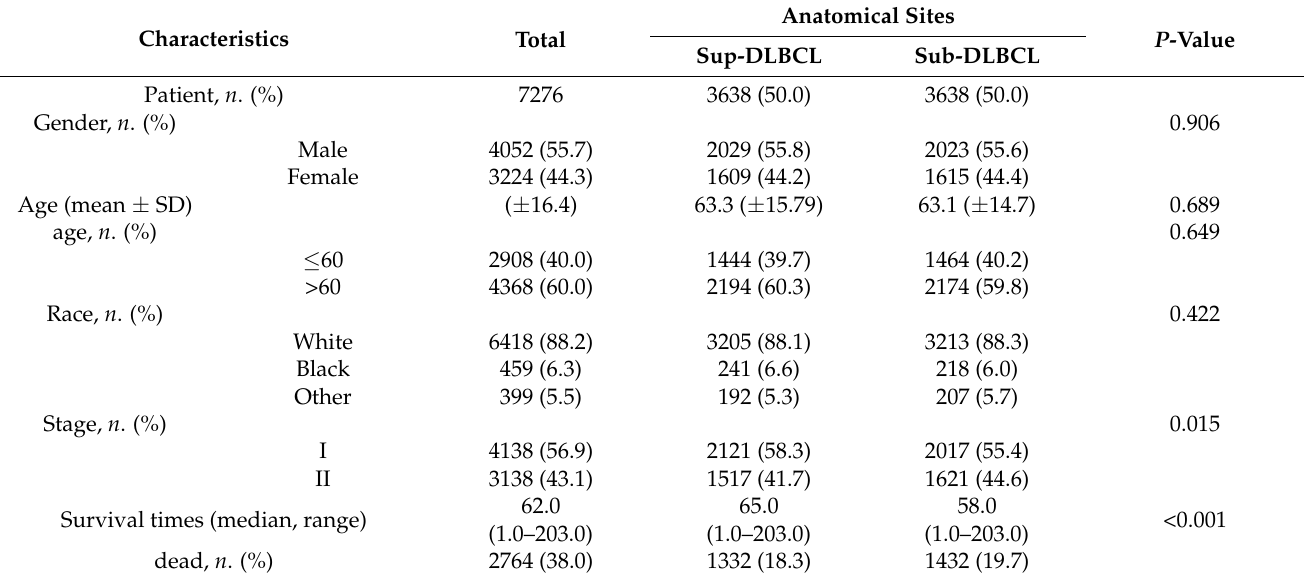
Table 3. Demographic characteristics of patients after PSM.